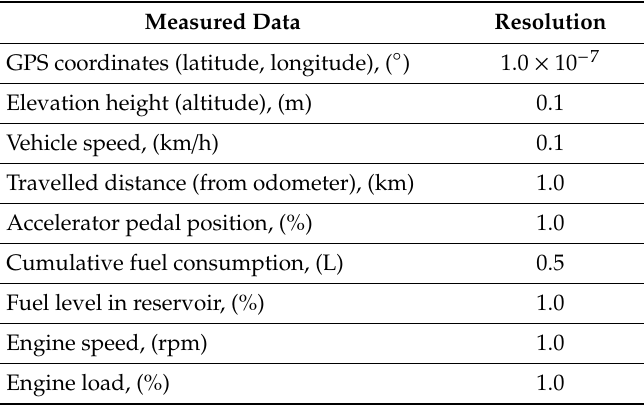
Figure 1. City bus routes in Dubrovnik along with end-station and depot locations. Table 1. List of available city bus tracking data.